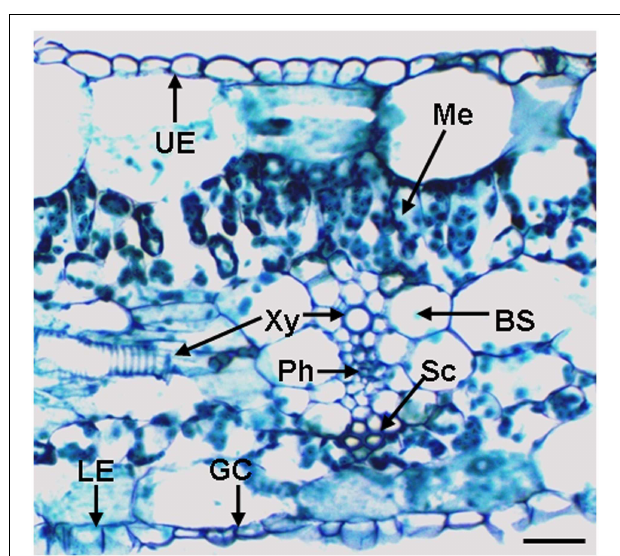
FIGURE 1 | Different responses of tolerant and sensitive banana ( Musa spp.) genotypes to low temperature stress. (A,B) The control plant and the youngest fully-developed leaf of Musa spp. ABB Dajiao (chilling-tolerant genotype). (C) The youngest fully-developed leaf of the tolerant genotype incubated at 10 ◦ C for 3 days. (D) The youngest fully-developed leaf of the tolerant genotype incubated at 7 ◦ C for 3 days, showing a slight loss in plant cell